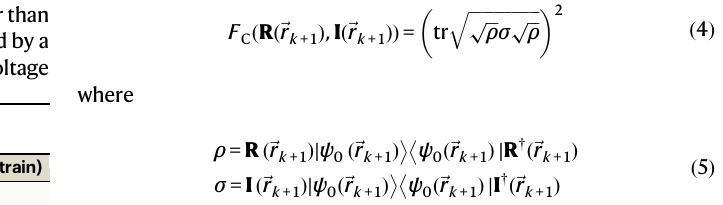
frequency of the ∣ +1 i $ ∣ (cid:4) 1 i transition. d Rabi frequency between ∣ e g + " E ∣ e for a single electrode pair in the strain-driving geometry. e Rabi frequency E E g (cid:4) # $ ∣ e g (cid:4) # after cross-talkelimination. f Rabifrequency along the between ∣ e g + " white dotted line in d .